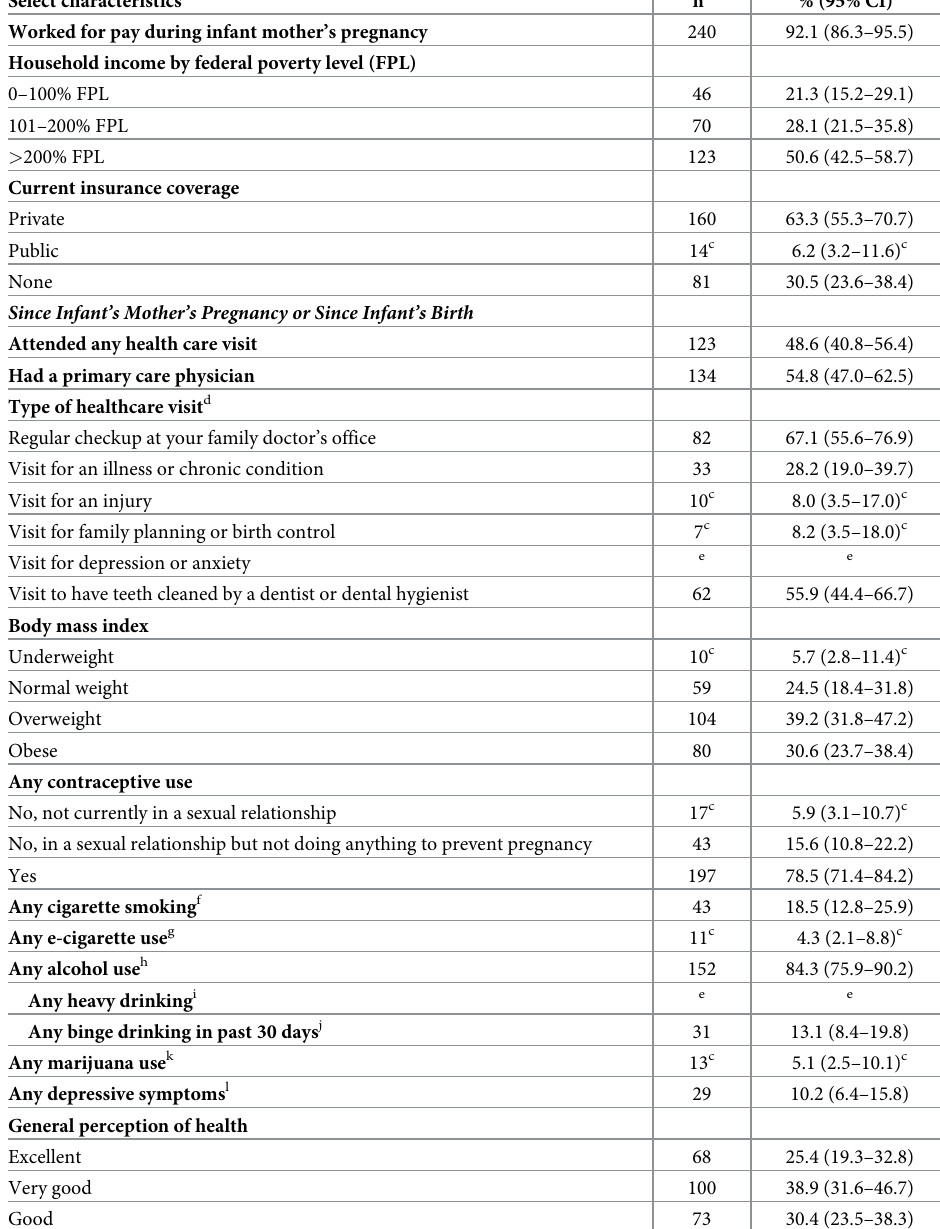
Table 4. Prevalence of select demographic and health characteristics and behaviors among respondents—The Pregnancy Risk Assessment Monitoring System for Dads pilot study, October 2018–July 2019, Georgia,